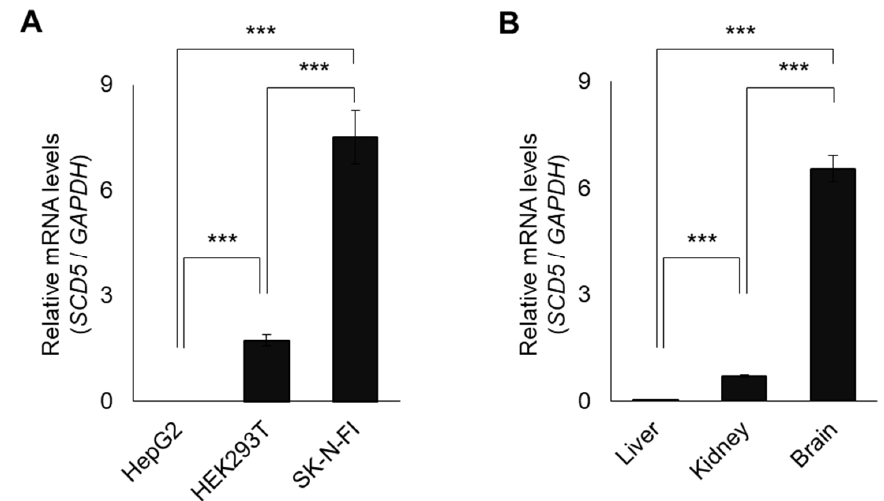
Figure 2. SCD5 mRNA expression in three different cell lines ( A ) and human tissues. ( B ) The mRNA expression was measured in HepG2, HEK293T, and SK-N-FI cells, as well as in human liver, kidney, and brain samples. Samples were prepared as described in Section 2. qPCR was performed using GAPDH and SCD5 sequence specific primers as indicated in Section 2. The diagram depicts the results of three independent measurements. Statistical analysis was performed by using the Tukey–Kramer Multiple Comparisons Test. Data are shown as mean values ± S.D. *** : p < 0.001.